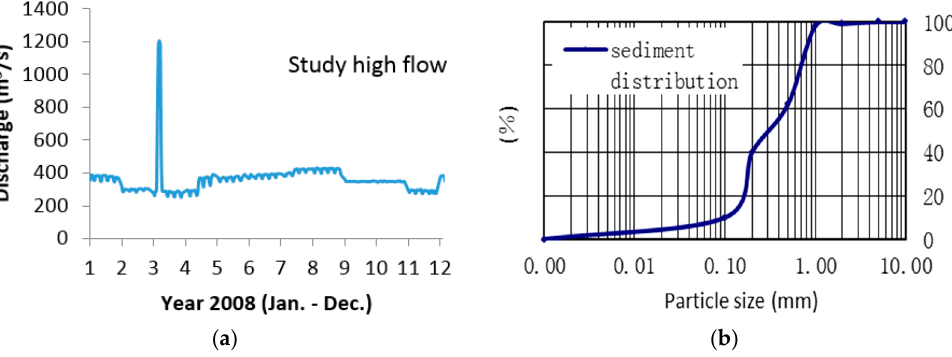
Figure 3. Daily mean discharge released from the Glen Canyon Dam during high flow effects in 2008 ( a ) and sediment distribution in the river bed during high flow effects in 2008 ( b ). Continuity